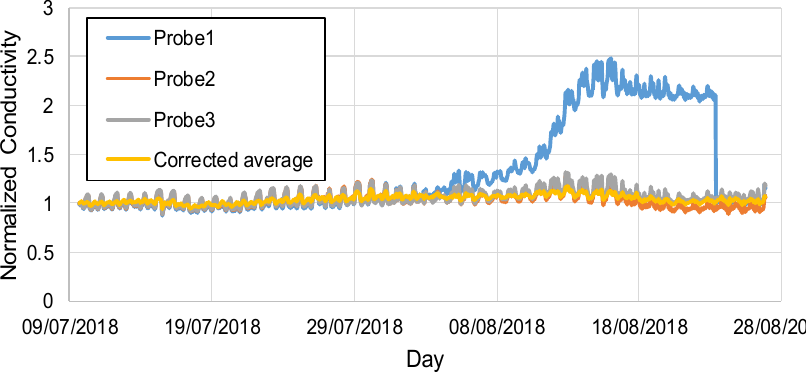
Figure 10. Normalized conductivity tracking for 3 identical probes in Node 3, showing fault detection and isolation of Probe 1 (whose fault was stimulated on purpose).